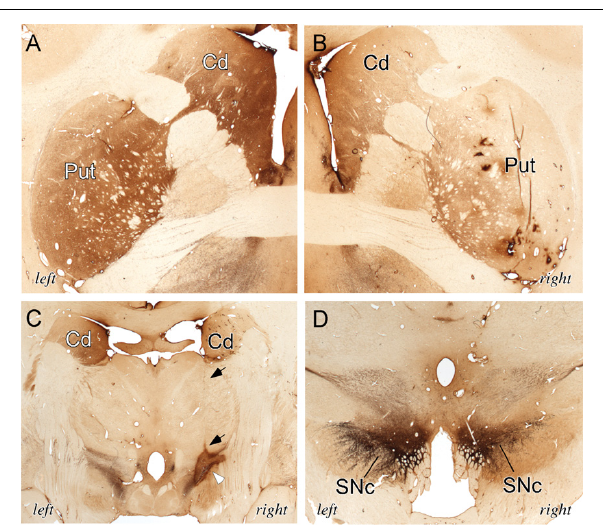
FIGURE 3 | Coronal brain sections showing tyrosine hydroxylase (TH) immunolabeling in the left and right hemispheres of the case-study monkey with a unilateral dopaminergic lesion. Images show the left (A) and right (B) hemispheres at the level of the anterior commissure. Note that theTH immunolabeling is much heavier in the left caudate (Cd) and putamen (Put) than on the right side. (C) Illustration of the track of the electrode (black arrows) that caused the lesion in the nigrostriatal pathway (white arrowhead). Note the asymmetry inTH immunolabeling between the left and right bodies of the caudate nucleus (Cd). (D) TH immunolabeling is weaker on the right versus left substantia nigra pars compacta (SNc). Also note that the subthalamic nucleus appears intact.